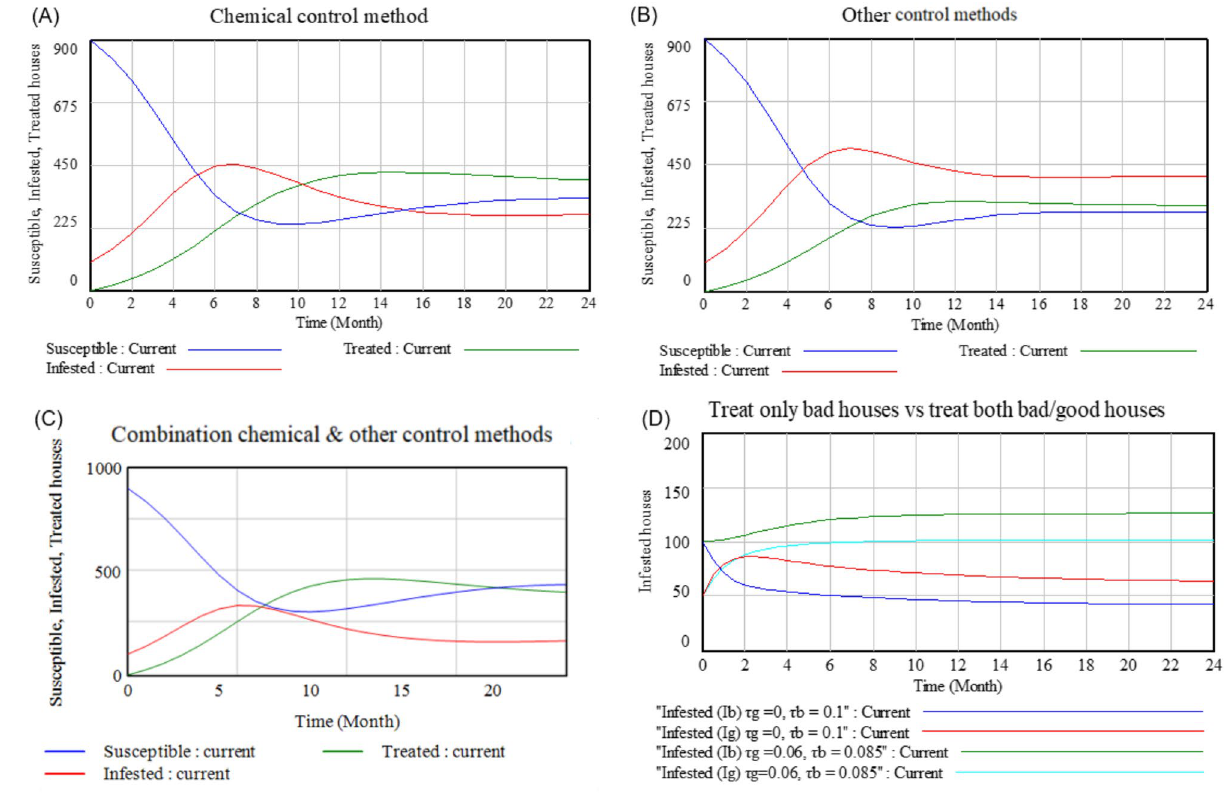
Figure 4. Control methods performance and management